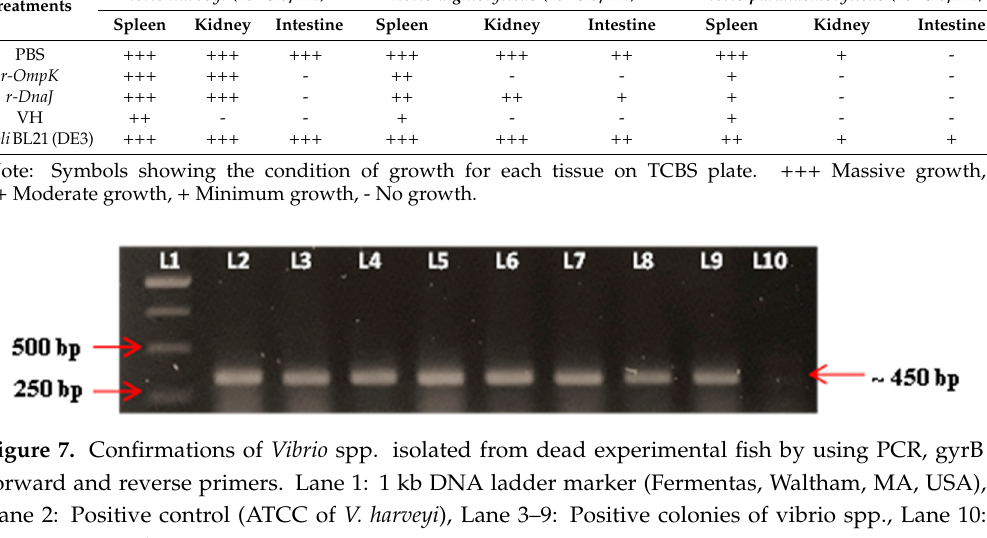
Table 5. Detection of yellow colonies of Vibrio on TCBS agar, isolated from the spleen, intestine, and kidney of fish challenged with V. harveyi , V. alginolyticus , and V. parahaemolyticus . Treatments